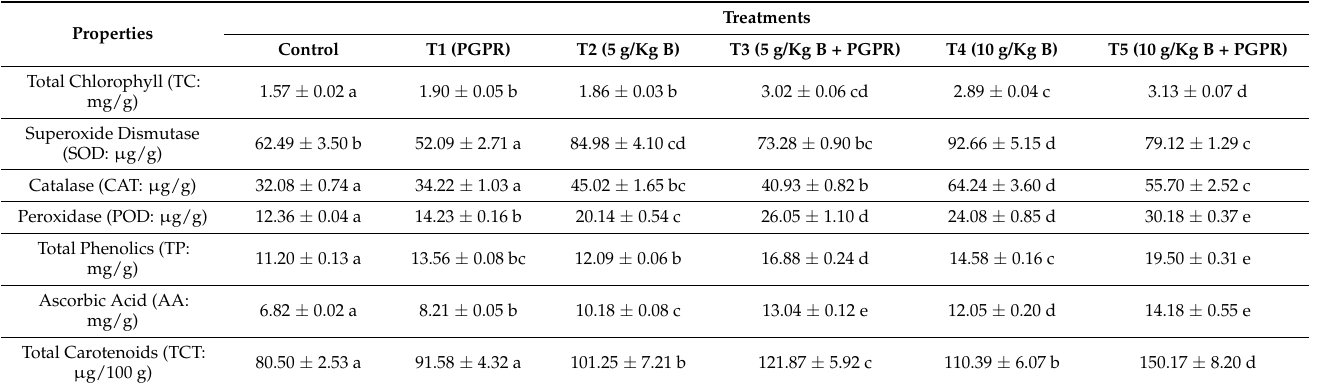
Table 4. Effect of different treatments of the spent mushroom substrate (SMS)-based biochar and PGPR on biochemical and enzyme activity characteristics of cauliflower ( B. oleracea